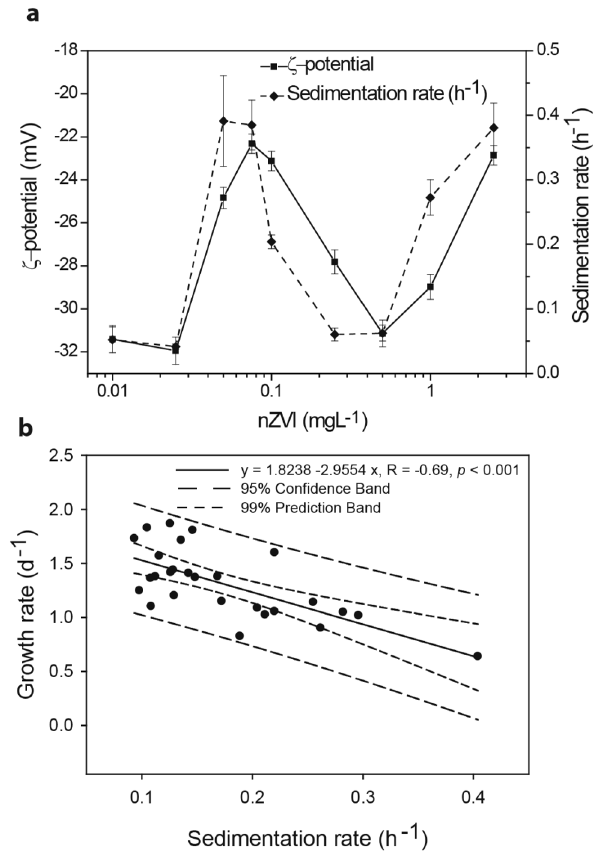
Figure 5. Toxicity of nZVI is mediated by colloidal destabiliza- tion and hetero-aggregation between algal cells and nZVI. (a) Sedimentation rates/ f -potential of test systems exposed to increasing concentrations of nZVI. (b) Correlation of sedimentation rates vs algal growth rates.